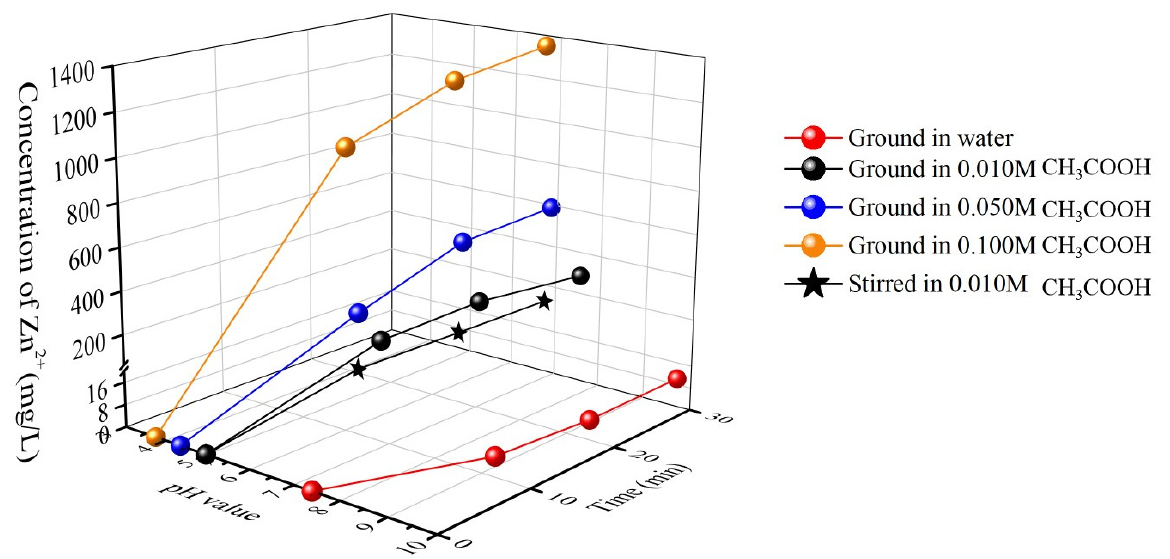
Figure 7. Concentrations of Zn 2+ ions and pH values of zinc oxide particles ground for di ff erent lengths of time in CH 3 COOH solutions with di ff erent concentrations.